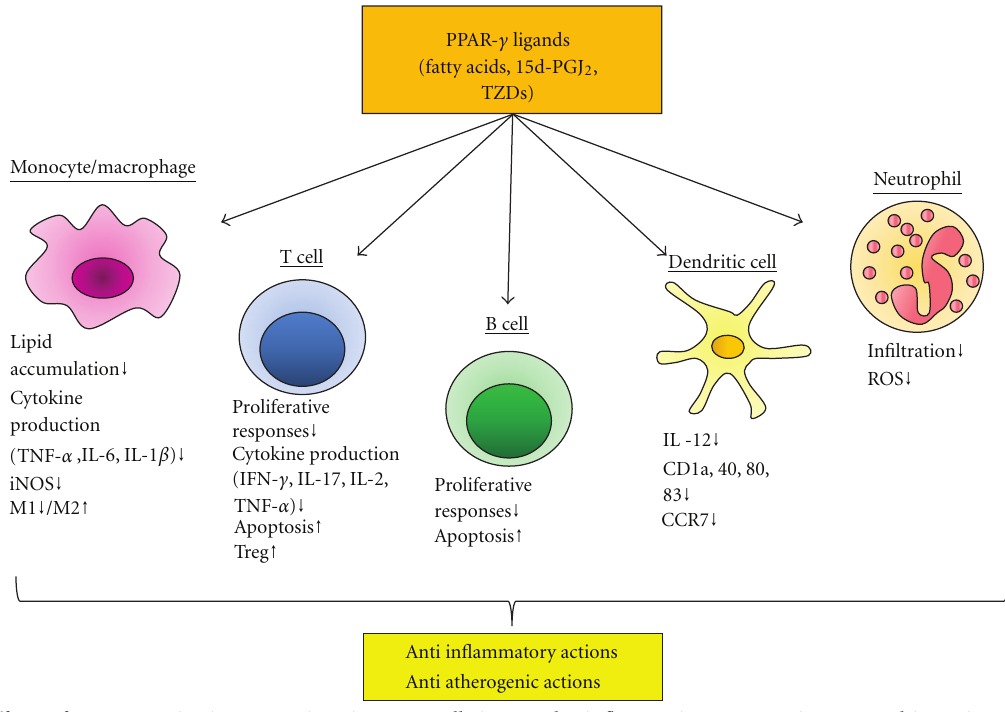
Figure 1: E ff ects of PPAR- γ activation on various immune cells in vascular inflammation. PPAR- γ is expressed in various immune cells such as monocyte/macrophage, lymphocyte, dendritic cell, and neutrophil. PPAR- γ activation by endogenous and synthetic ligands could regulate inflammatory responses induced by these cells, leading to anti-inflammation and antiatherogenicity. CCR, chemokine (C-C motif) receptor; 15d-PGJ2, 15-deoxy- Δ 12,14 -prostaglandin J 2 ; IFN, interferon; IL, interleukin; ROS, reactive oxygen species; TNF, tumor necrosis factor; Treg, regulatory T cell; TZD,